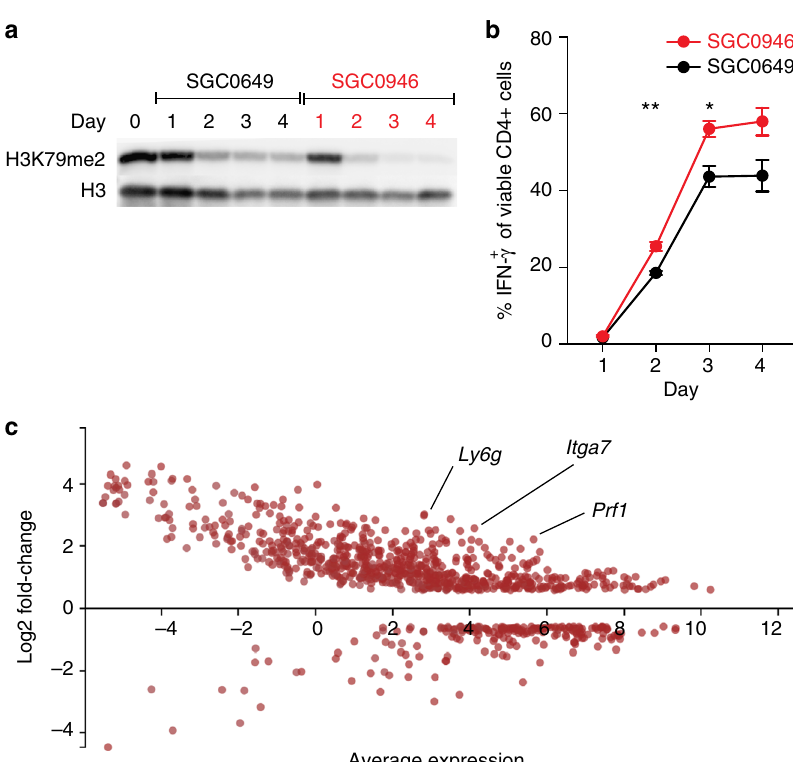
Fig. 5 DOT1L-dependent H3K79me2 is dynamically regulated at lineage-speci fi c promoters. a Analysis of H3K79me2 in CD4 + T cells under Th1 polarizing conditions in the presence of the DOT1L inhibitor SGC0946 (1 µ M) or the control compound SGC0649 (1 µ M) with time as measured by western blot. b Analysis of IFN- γ production by FACS under the same conditions as in a . Signi fi cant differences are indicated with an asterisk and were calculated using one-way ANOVA (* p ≤ 0.05, ** p ≤ 0.01). Data shown are representative of three independent experiments. c DOT1L-dependent regulation of